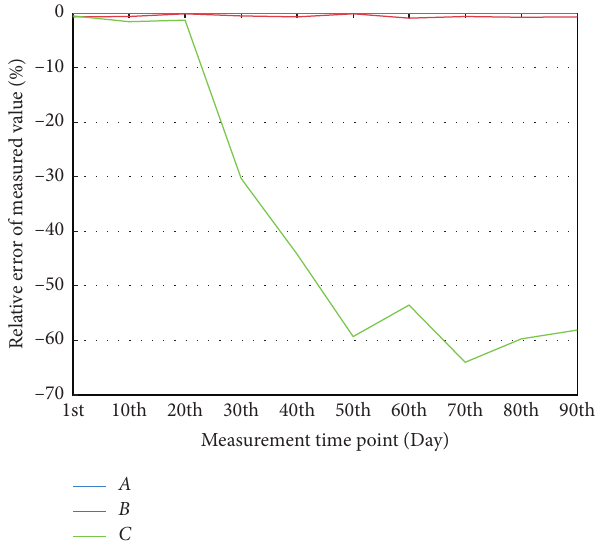
Figure 8: Relative errors with A of ultrasonic cleaning probe and noncleaning probe.